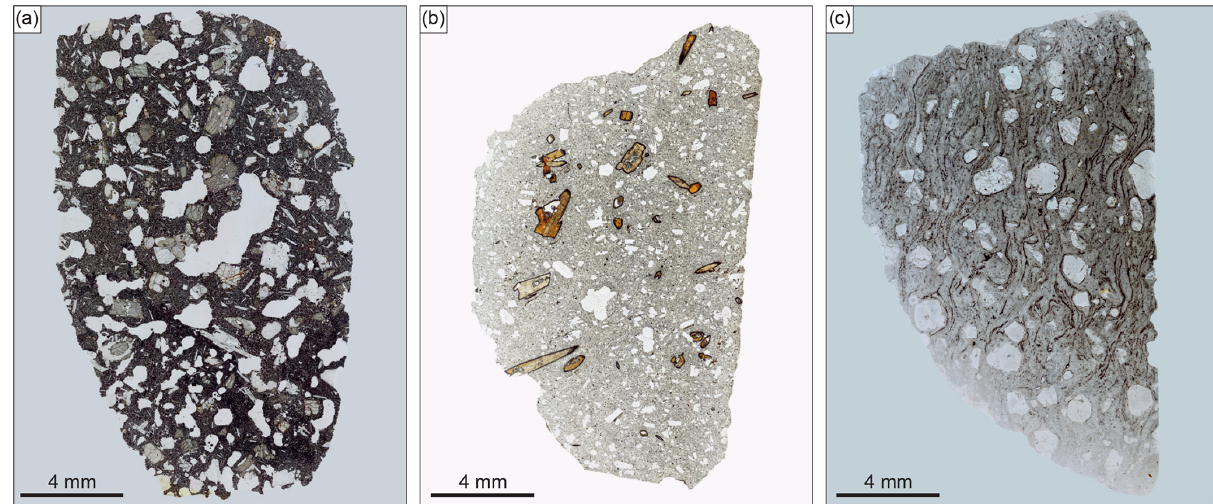
Figure 1. Thin section samples selected for use in the prototype learning resource: (a) basalt, (b) andesite, and (c) rhyolite.